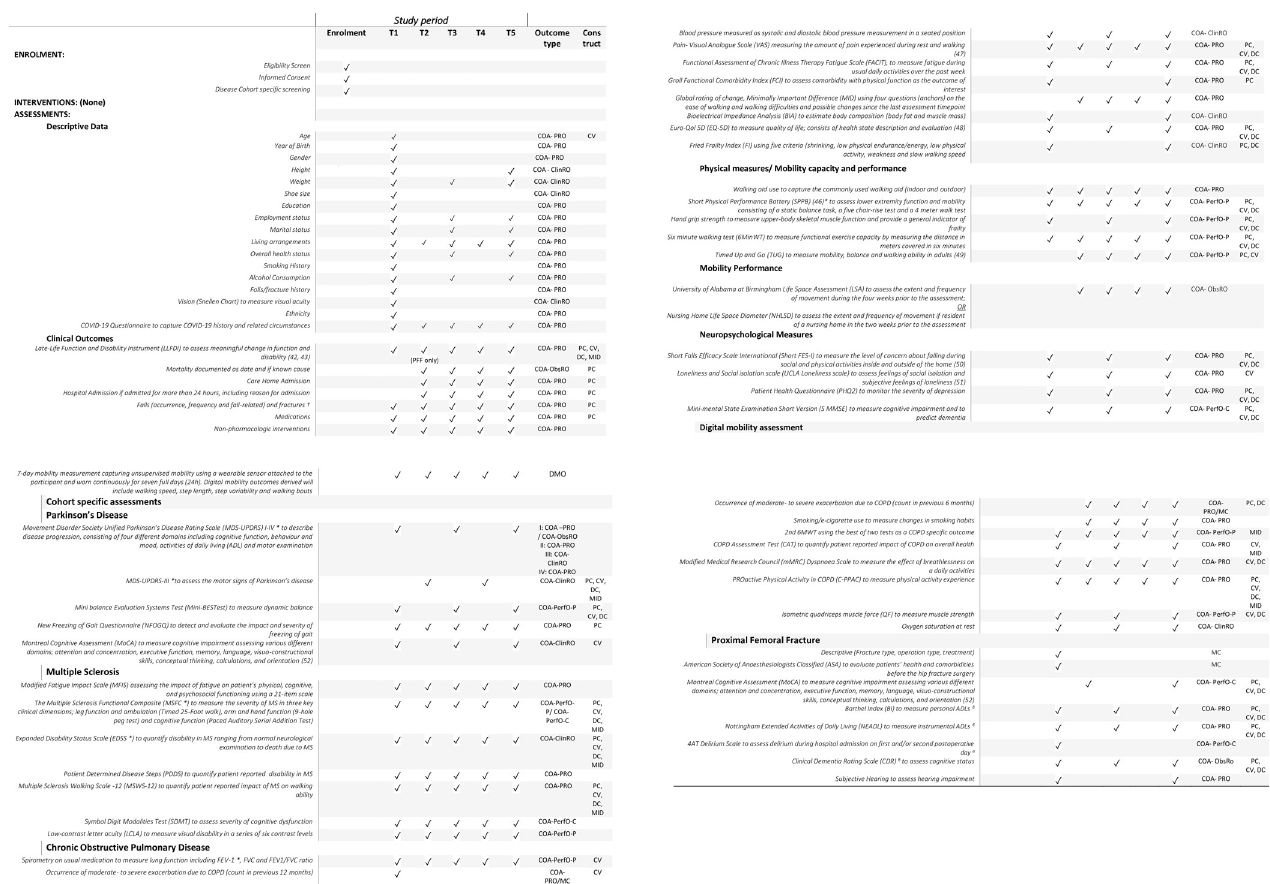
Fig 1. List of assessments and outcomes collected during screening, baseline assessment and every six months. T1, Screening/Baseline; T2, 6 month assessment; T3, 12 month assessment; T4, 18 month assessment; T5, 24 month assessment; � , indicates key (primary) cohort specific outcome measure; SPPB, short physical performance battery–PFF key primary cohort specific outcome measure; † falls and fracture data are collected retrospectively, 12 month retrospective at T1 and 6 month retrospective at T2-T5; β , pre-fracture status is measured at T1, current status is measured at T3 and T5; α , only applicable to acute patients; Outcome type, type of outcome measure in accordance with FDA terminology; COA, clinical outcome measure–describes or reflects how a patient feels, functions, or survives; PRO, Patient-reported outcome; ObsRO–Observer-reported outcome; ClinRO, Clinician-reported outcome; PerfO, Performance-based outcome; PerfO-P, Performance-based outcome physical measure; PerfO-C, Performance-based outcome cognitive/mental measure; Construct, validation construct assessed; PC, predictive capacity; CV, construct validity; DC, detect change over 24 months; MID, Minimum Important Difference; MC, medical